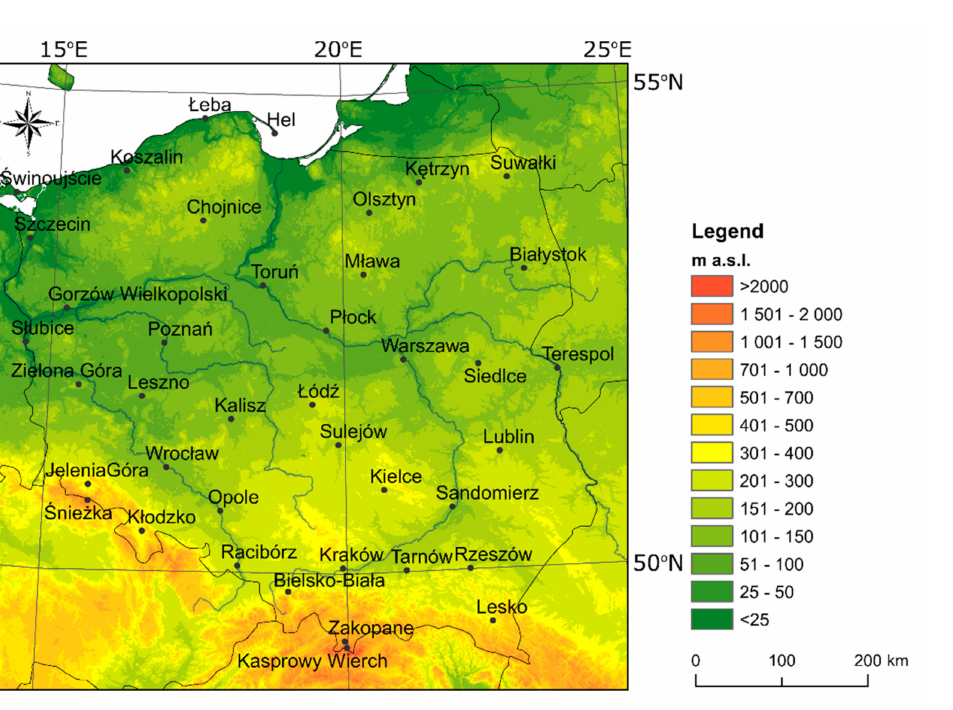
Figure 1. Location of